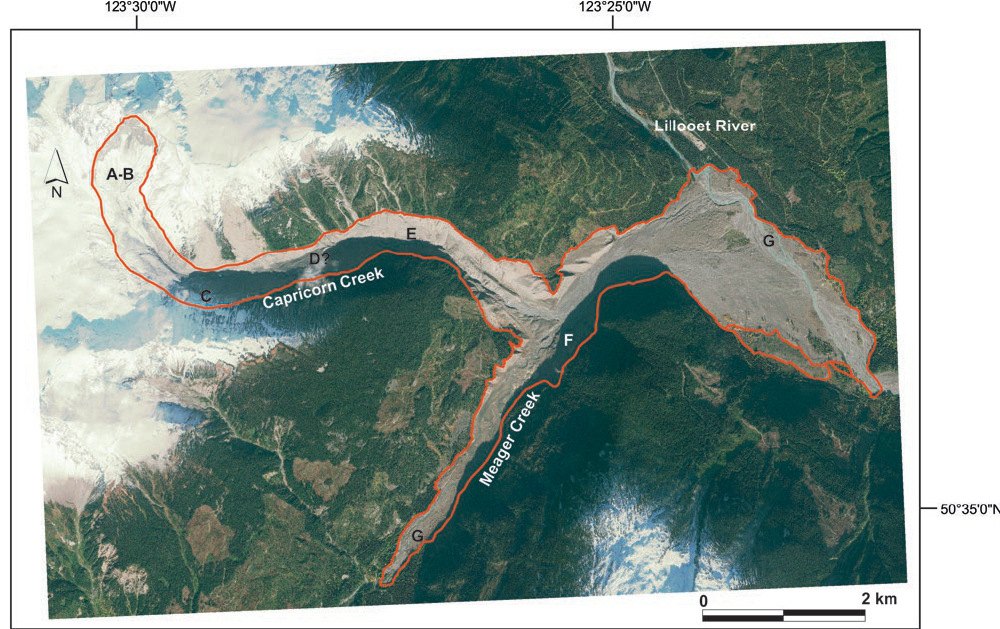
Fig. 9. The complete outline of the Mount Meager landslide showing the initiation zone (A–B), the two major bends (C and E), the facing wall of Meager Creek (F), and the bifurcated flow that travelled up Meager Creek, and across the Lillooet River (G). The image was taken following the breach of the Meager Creek dam, and fluvial reworking and considerable incision of the dam itself are evident.